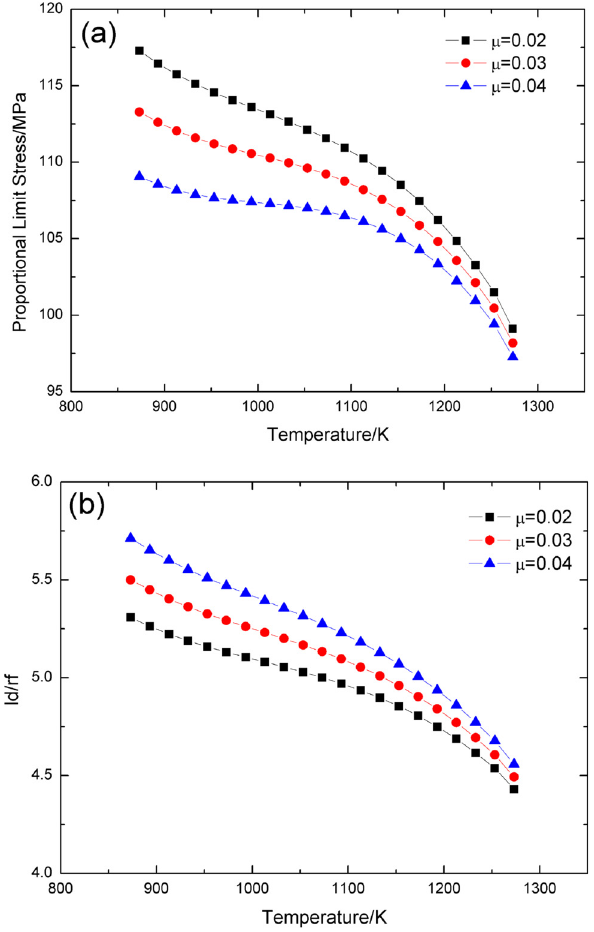
Figure 3: E ff ect of the interface frictional coe ffi cient on ( a ) the PLS versus temperature curves and ( b ) the fi ber/matrix interface debonding length versus temperature curves of SiC/SiC